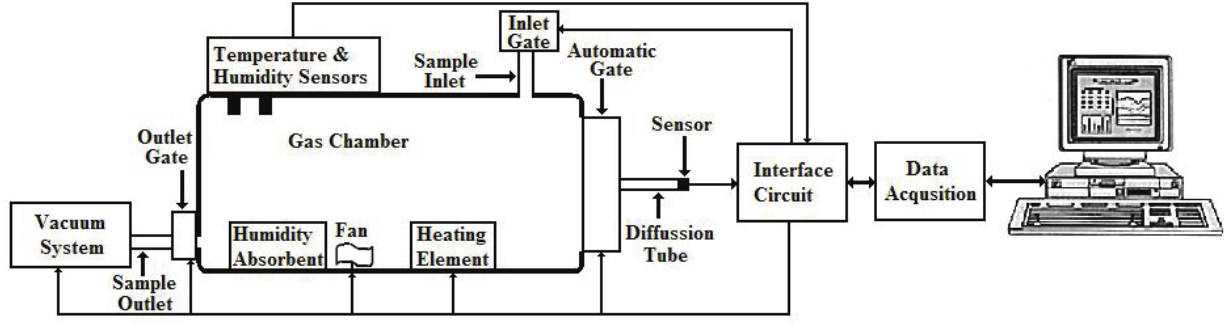
Figure 2. Schematic diagram of the measurement system